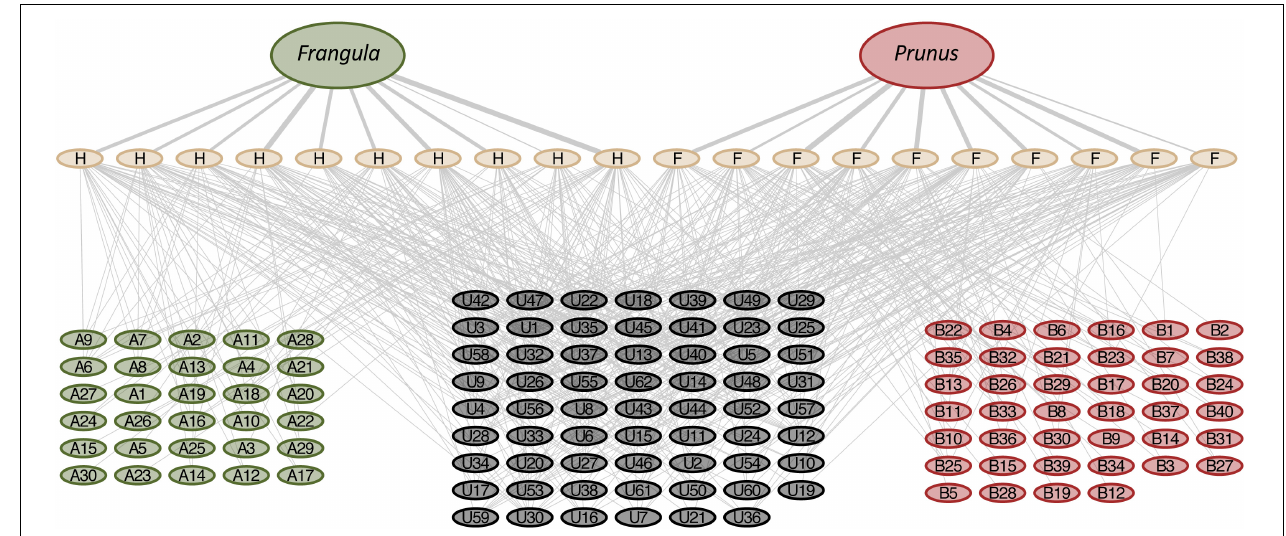
FIGURE 3 | Tripartite network relating plant diet ( Frangula californica and Prunus fasciculata ) to individual woodrat fecal samples from the hill (H) and the flats (F) habitats and the metabolites ( m/z features) identified through LC-MS of their respective fecal samples. The metabolites cluster into three groups, those that are shared between all rats (gray), those unique to hill rats consuming F. californica (green) and those unique to flat rats consuming P. fasciculata